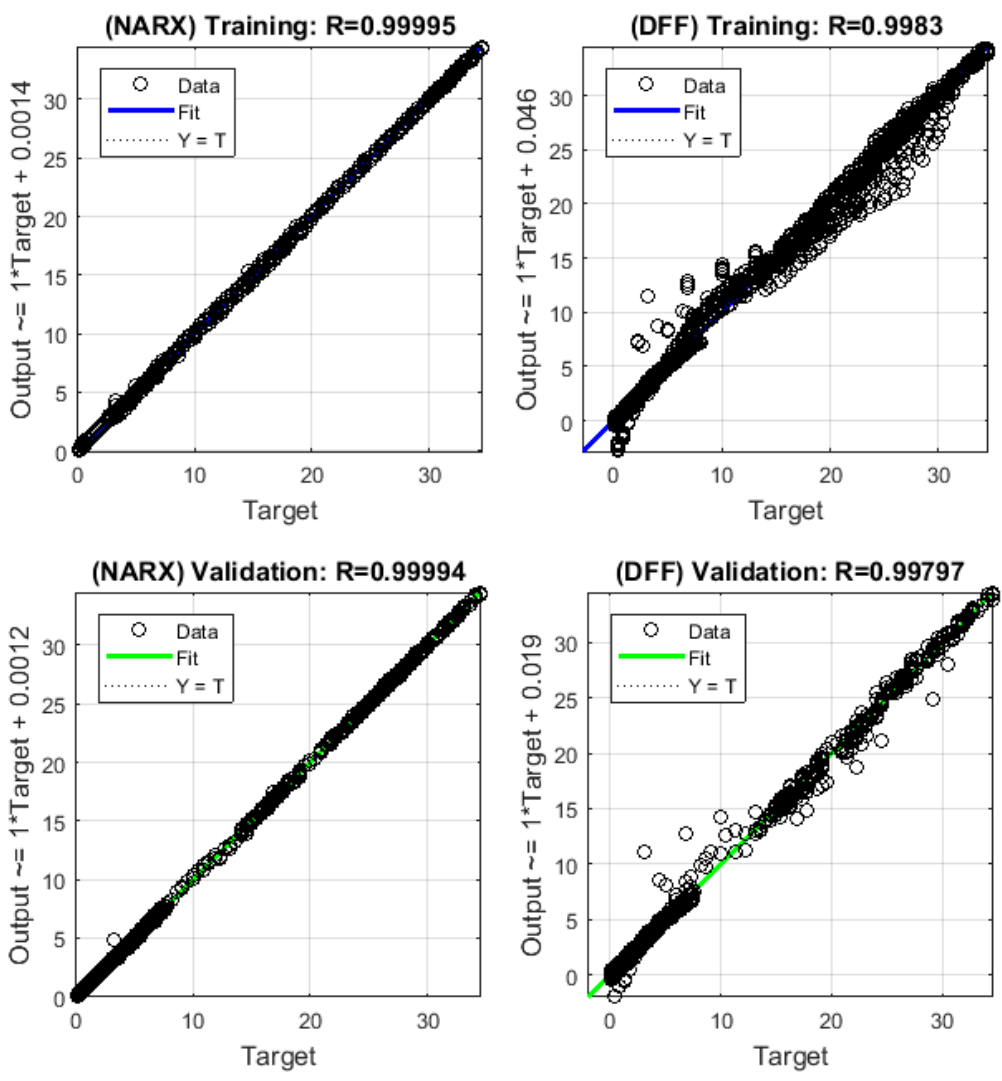
Figure 7. Regression of error for both the NARX and DFF neural networks.